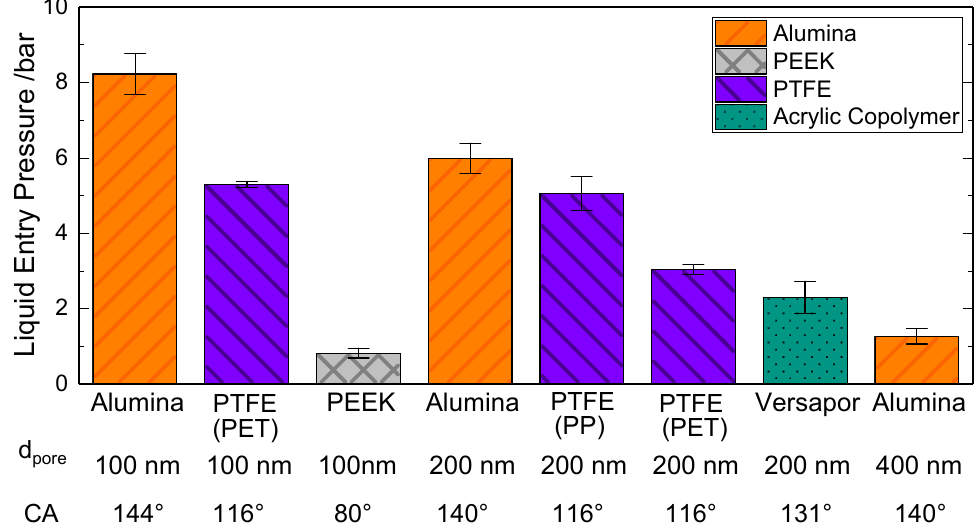
Figure 6. Results of LEP measured by the visual method at ambient conditions T = 25 °C, p = 1 bar together with the mean pore size of the membrane (d pore ) and the measured static contact angle values (CA).